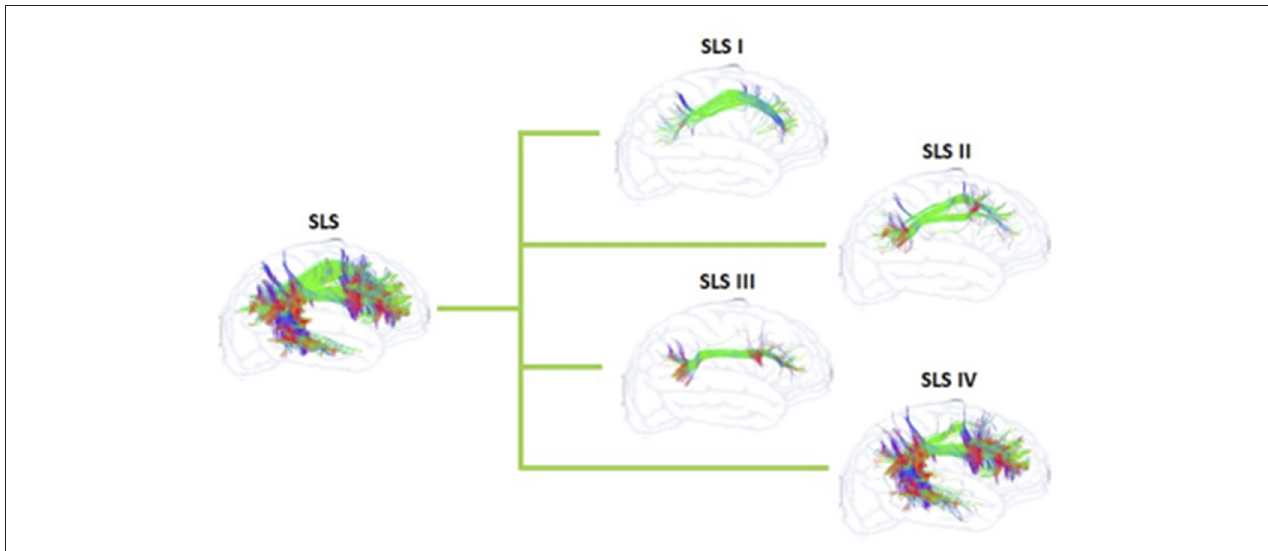
FIGURE 6 | Schematization of the SLS and its sub-systems of the proposed nomenclature by Mandonnet et al. (5) for the human white matter association pathways.